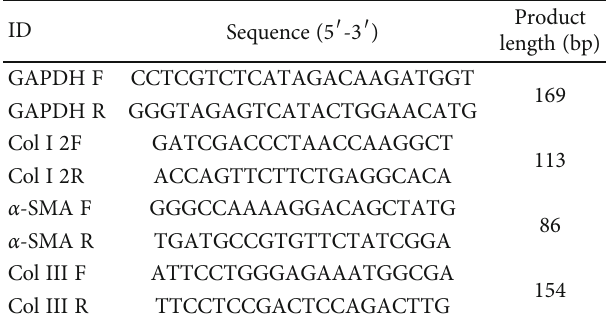
Table 1: Primers ’ sequences used in qRT-PCR in this study.